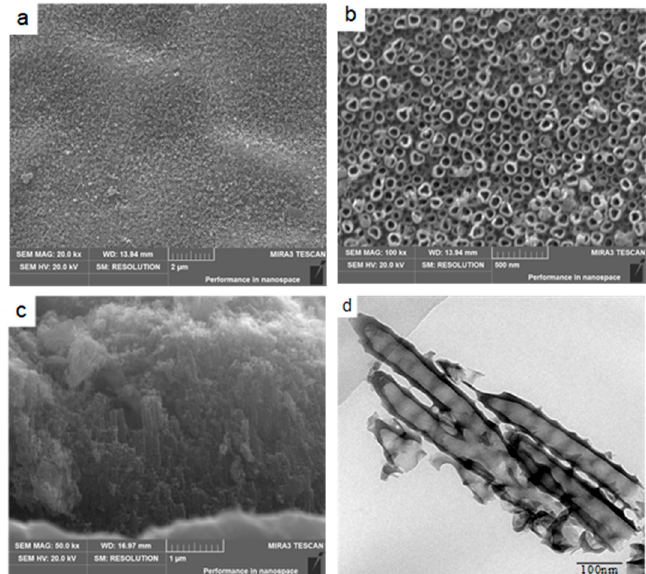
Figure 2. ( a ) SEM image of the TiO 2 nanotube array formed by anodization in 0.3 mol/L NH 4 F + glycerol–water (volume ration 1:1) at 20 V, ( b ) higher magnifications of the TiO 2 nanotube array, ( c ) cross-section of the TiO 2 nanotube array, and ( d ) bright field TEM image of the nanotubes.